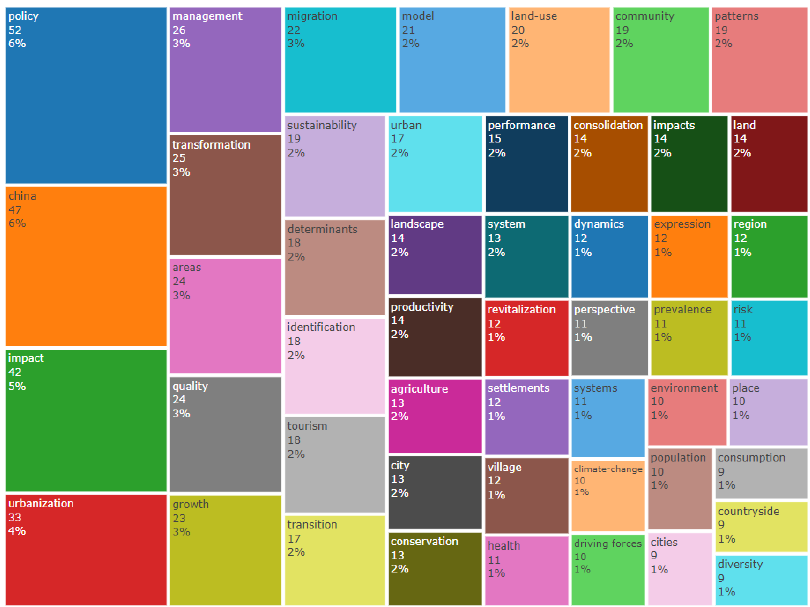
Figure 8. Keywords used frequently in studies on rural revitalization from 1991 to 2021.